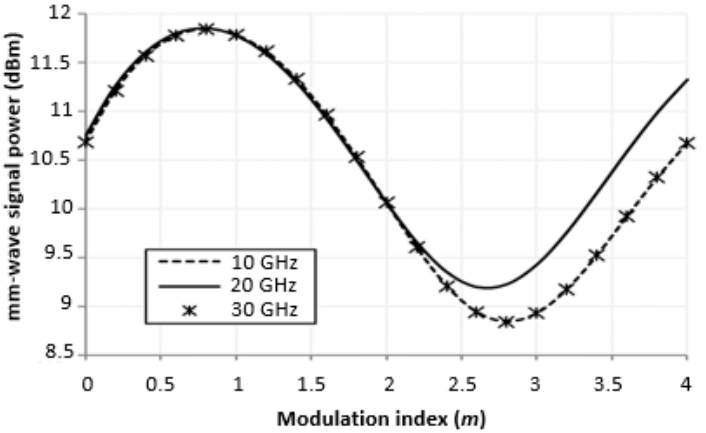
Figure 3. Signal power of optical mm-wave as a function of modulation index ( m ) for different LO frequencies.